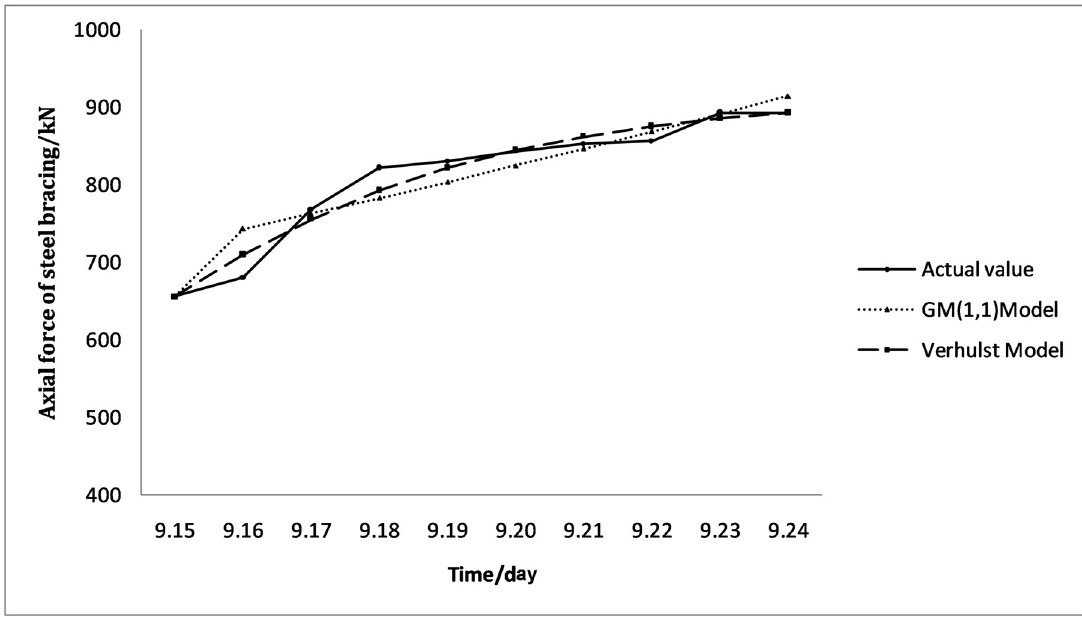
Fig 8. Comparison of ZG53-4 the actual value and the model